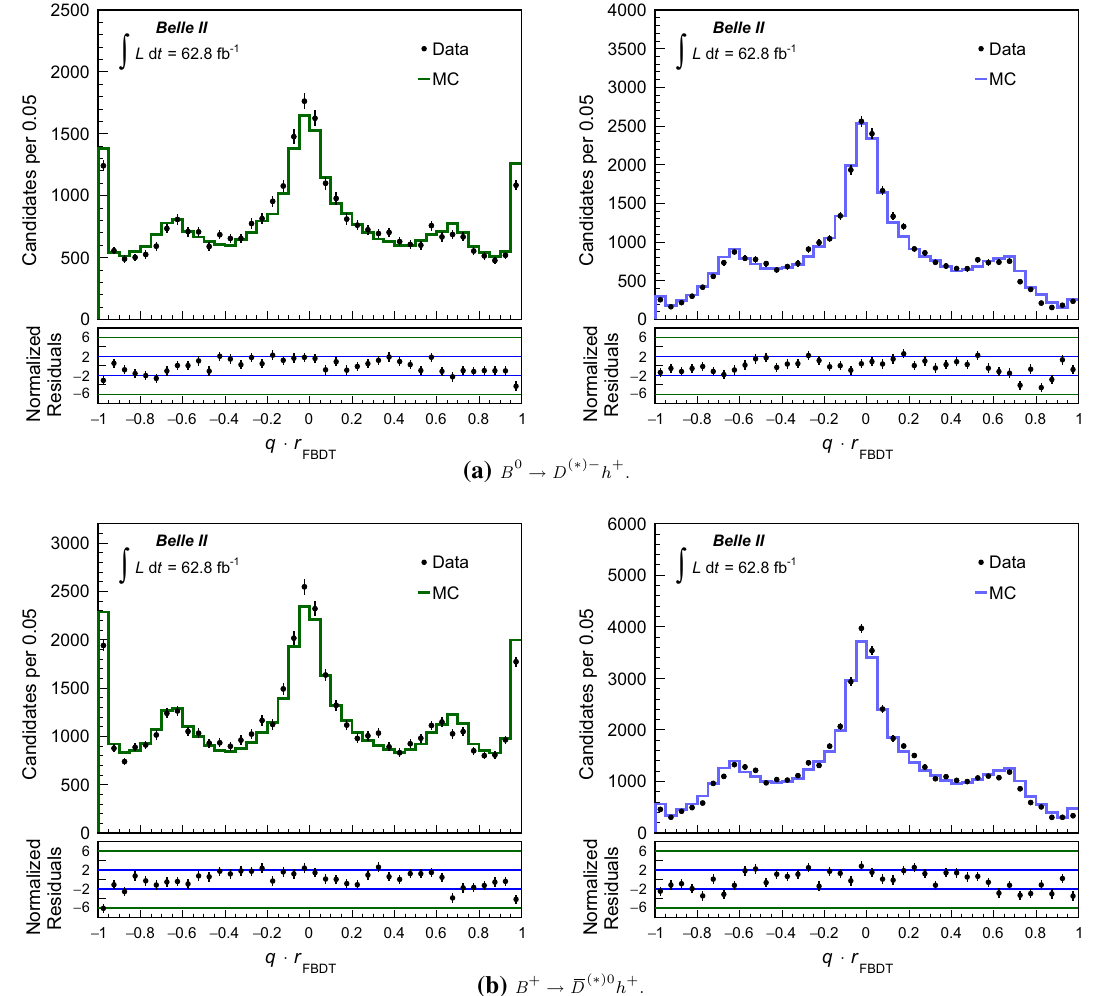
Fig. 7 Normalized q · r distributions obtained with the category-based tagger in data and MC simulation. The contribution (left) from the sig- nal component in data is compared with correctly associated signal MC